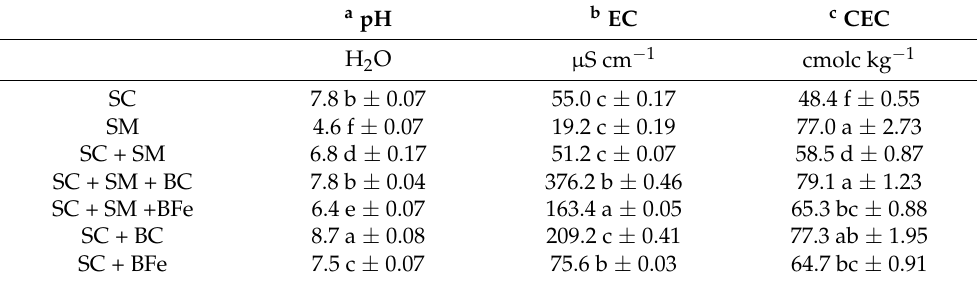
Table 4. Chemical attributes of the soil after experiment.